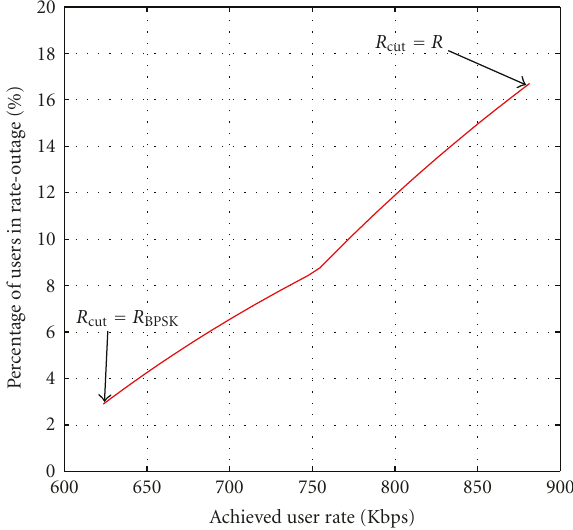
Figure 10: Tradeo ff between the achieved user rate and the percentage of users in rate outage for U = 100 users and P tot = 10 W (WASNR (cid:11) 25dB).